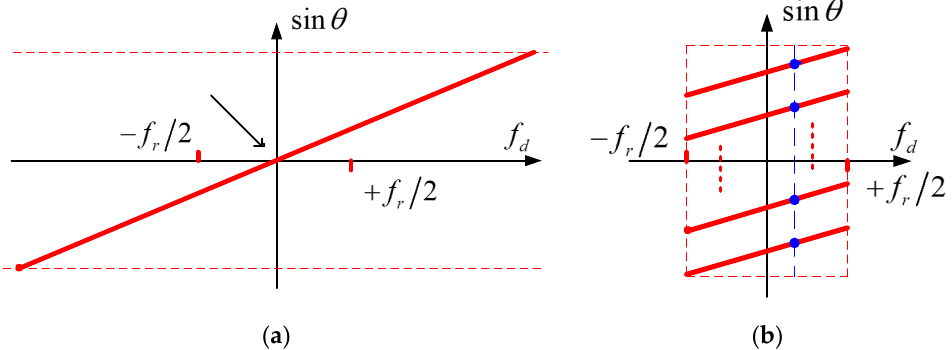
Figure 2. Spatial-time spectrum ( a ) without Doppler ambiguity and ( b ) with Doppler ambiguity. In the HRWS SAR imaging, the pulse repetition frequency (PRF) f r is usually much lower than the instantaneous Doppler bandwidth. Thus, the Doppler spectrum is and the reference EPC for the same Doppler bin